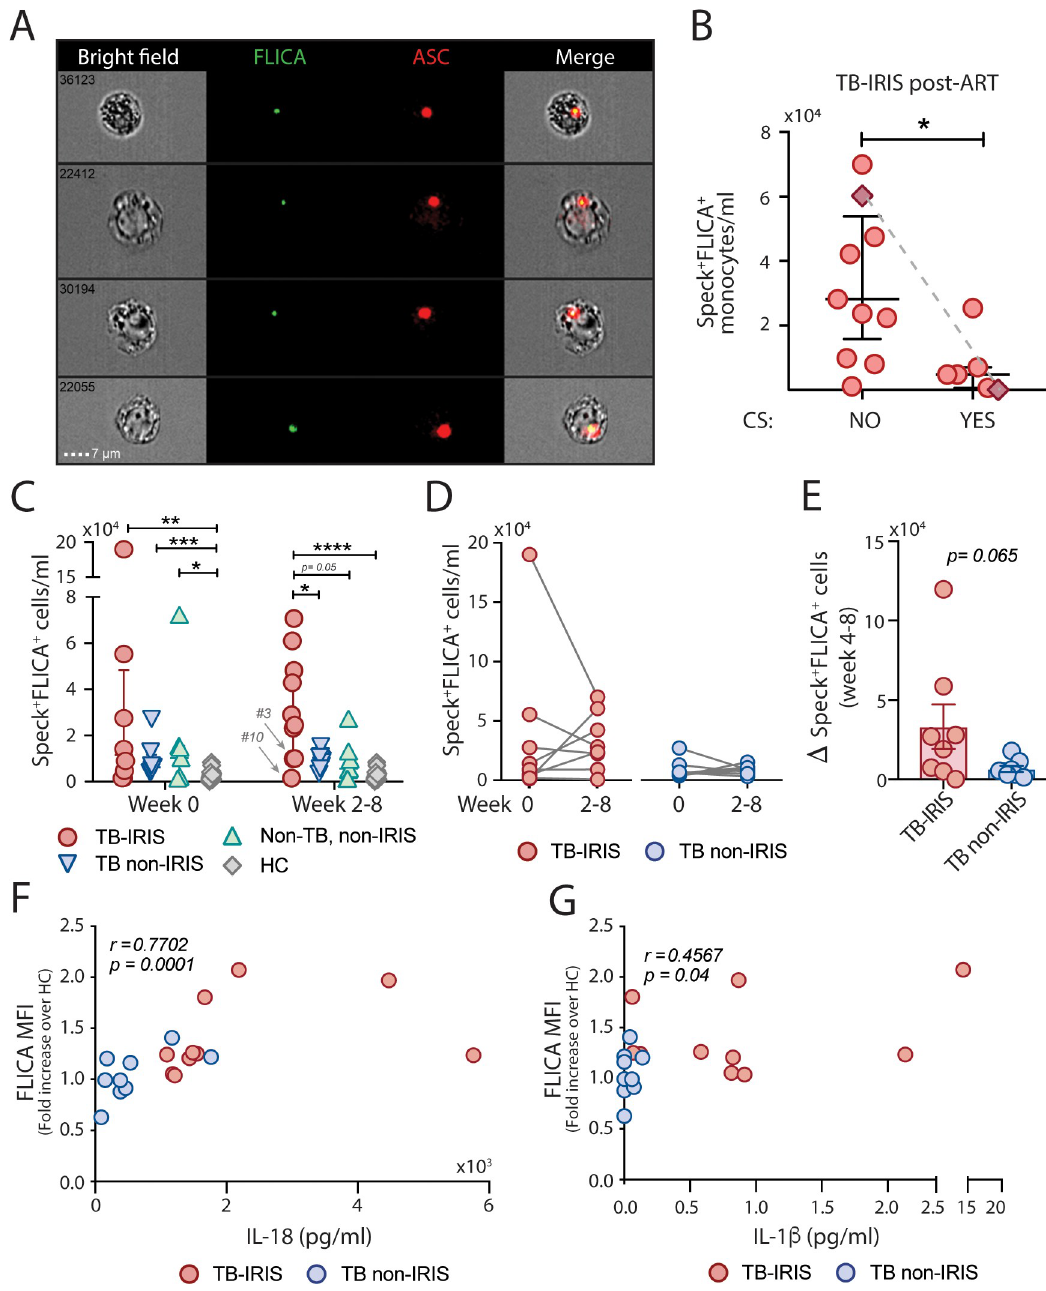
Fig 2. Elevated numbers of monocytes containing FLICA + ASC-speck formation is found during TB-IRIS events. ( A ) PBMCs from healthy donors (n = 22) and TB-IRIS (n = 14), TB-non IRIS (n = 9) and Non-TB, non-IRIS (n = 7) patients, before (Week 0) or after ART initiation (Week 2–8), were incubated with the fluorochrome inhibitor of caspase-1/4/5 (FLICA), stained for monocyte identification and intracellular ASC and acquired by using Imaging flow cytometry. Representative images showing co- localization of active caspase-1/4/5 with ASC Specks were selected from a TB-IRIS patient, after Bright Detail Similarity R3_MC_11-ASC_2-FLICA was applied inside the Speck + gate. Images show respectively: BF (brightfield), FLICA and ASC fluorescences followed by a composite image containing BF and the fluorescence of ASC and FLICA merged. Note: The fluorescence intensity of the images may have been modified, without affecting results and statistics. ( B and C ) The number of monocytes showing spontaneous FLICA + ASC-Speck formation was quantified after application of Modulation_Morphology (M11,Ch11)_11-ASC feature, followed by Bright Detail Similarity R3_MC_11-ASC_2-FLICA, inside the “Total Monocytes” gate, by using IDEAS software. Data are presented as median with interquartile range. � P < 0.05, �� P < 0.01 and ���� P < 0.001, when Mann-Whitney test was applied. ( D ) Longitudinal analysis of pre-ART versus post-ART timepoints for the amount